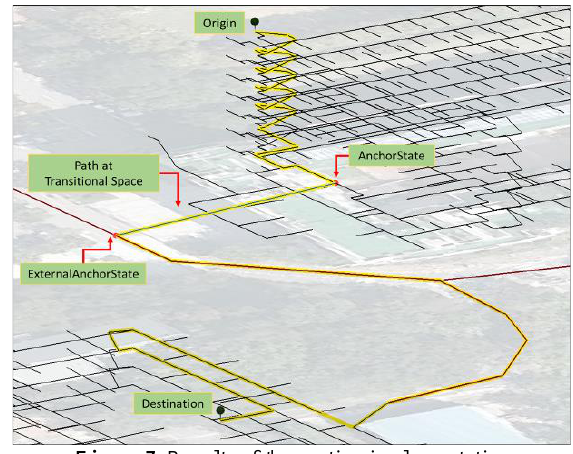
Figure 7 . Results of the routing implementation